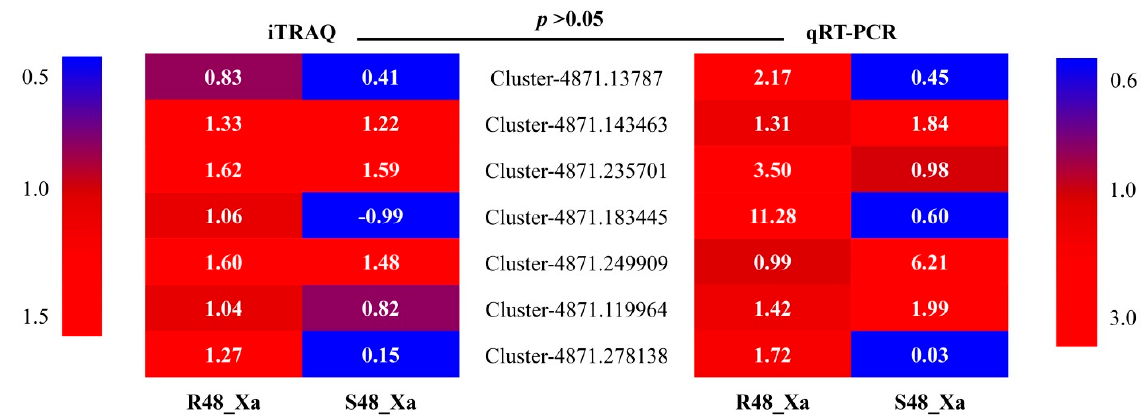
Figure 5. Relative expression levels (values in boxes) of seven sugarcane genes based on iTRAQ (log 2 Fold Change) and qRT-PCR (2 – ΔΔ CT ) data of two cultivars inoculated with Xanthomonas albilineans . Data were recorded at 48 h post inoculation: R48_Xa for leaf scald-resistant cultivar LCP 85–384 and S48_Xa for leaf scald-susceptible cultivar ROC20. The paired comparison T-test was used to determine if differences between iTRAQ (log 2 Fold Change) and qRT-PCR (2 – ΔΔ CT ) data were significant at p = 0.05. Four genes were highly expressed in the leaf scald resistant and susceptible cultivars as compared to the pathogen-free control plants: GAPC3 coding for the cytosolic glyceroldehyde-3-phosphate dehydrogenase, UGT coding for the UDP-glycosyltransferase, nsLTP coding for the non-specific lipid transfer protein, and UBA1 coding for the ubiquitin-activating enzyme E1 (Figure 6). Three genes coding respectively for the photosystem I P700 apoprotein A1 ( psaA , Cluster-4871.13787), a non-specific lipid-transfer protein ( nsLTP , Cluster-4871.183445), and the ubiquitin-activating enzyme E1 ( UBA1 , Cluster-4871.278138) were all downregulated in ROC20 in comparison to pathogen-free control plants. The UDP-glycosyltransferase ( UGT , Cluster-4871.235701) and nsLTP gene (Cluster-4871.183445) were highly upregulated ( p < 0.01) in resistant cultivar LCP 85–384 with 3.5- and 9.9-fold changes, respectively. The psaA gene was also significantly highly expressed ( p < 0.05), with a fold change of 2.1 in LCP 85–384. The genes coding for cytochrome P450 ( P450 , Cluster-4871.249909), the cytosolic glyceroldehyde-3-phosphate dehydrogenase ( GAPC3 , Cluster-4871.143463), and the argonaute family protein ( AGO , Cluster-4871.119964) were significantly upregulated with 5.3-, 1.8-, and 1.7-fold change, respectively, in ROC20. The UBA1 (Cluster-4871.278138) gene was significantly upregulated